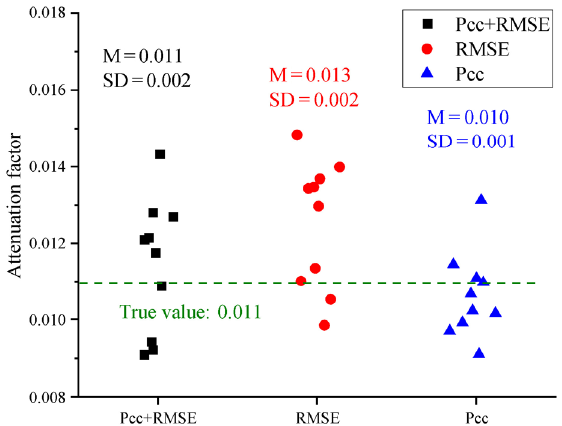
Fig. 11 Effect of different objective functions on the inversion results of the attenuation